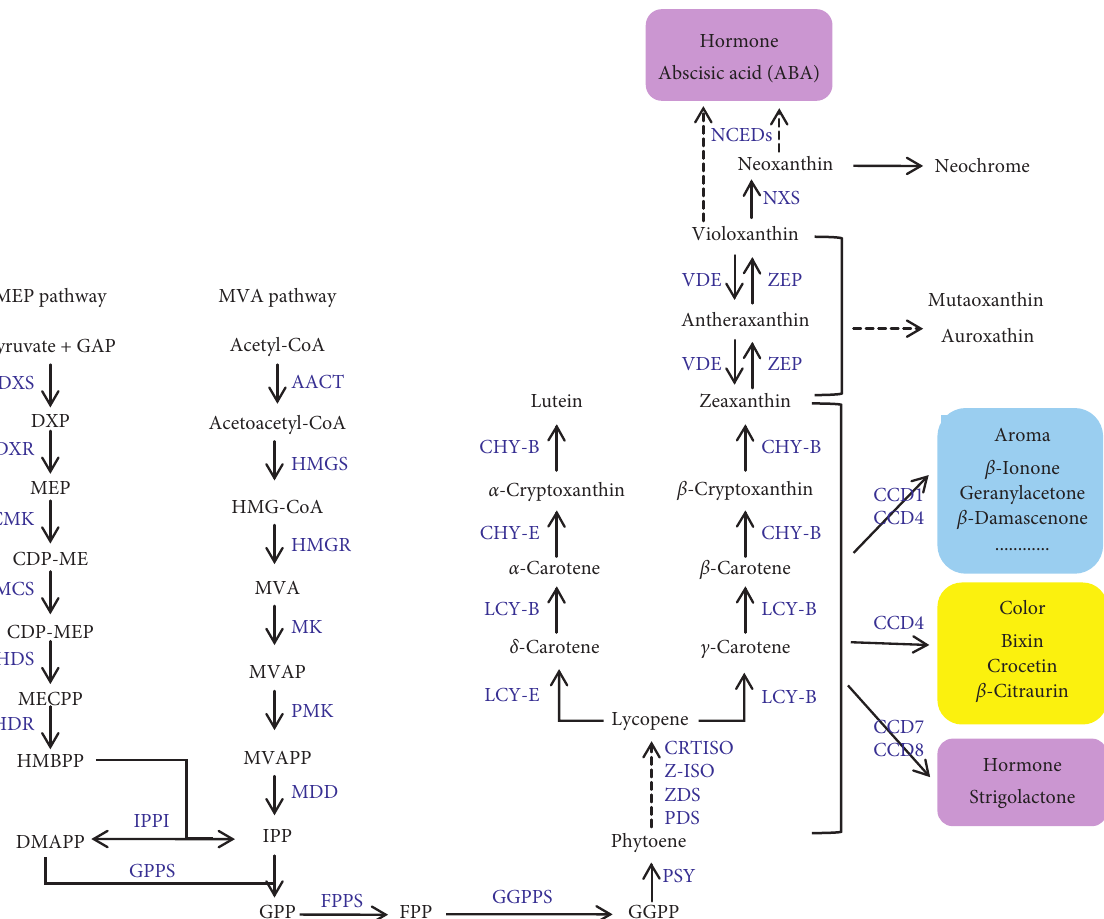
Figure 2: Biosynthetic pathway of apocarotenoid aroma in horticultural plants. GAP, glyceraldehyde-3-phosphate; DXP, 1-deoxy- D-xylulose-5-phosphate; DXS, 1-deoxy-D-xylulose-5-phosphate synthase; DXR, 1-deoxy-D-xylulose-5-phosphate reductase; MEP, 2-C-methyl-D-erythritol-4-phosphate; CMK, 2-phospho-4-(cytidine 5 ′ -diphospho)-2-C-methyl-D-erythritol kinase;